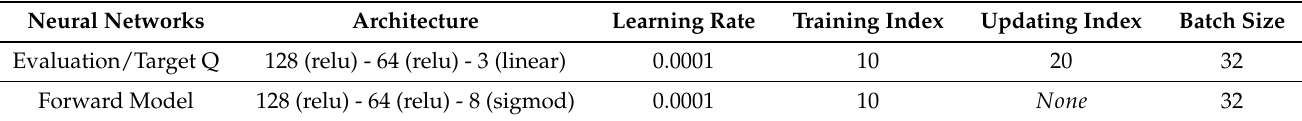
Table 2. Parameters for neural